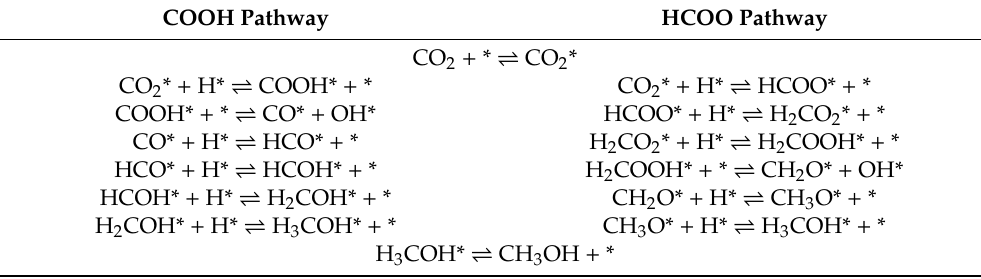
Table 5. CO 2 hydrogenation mechanisms; this table was reproduced from